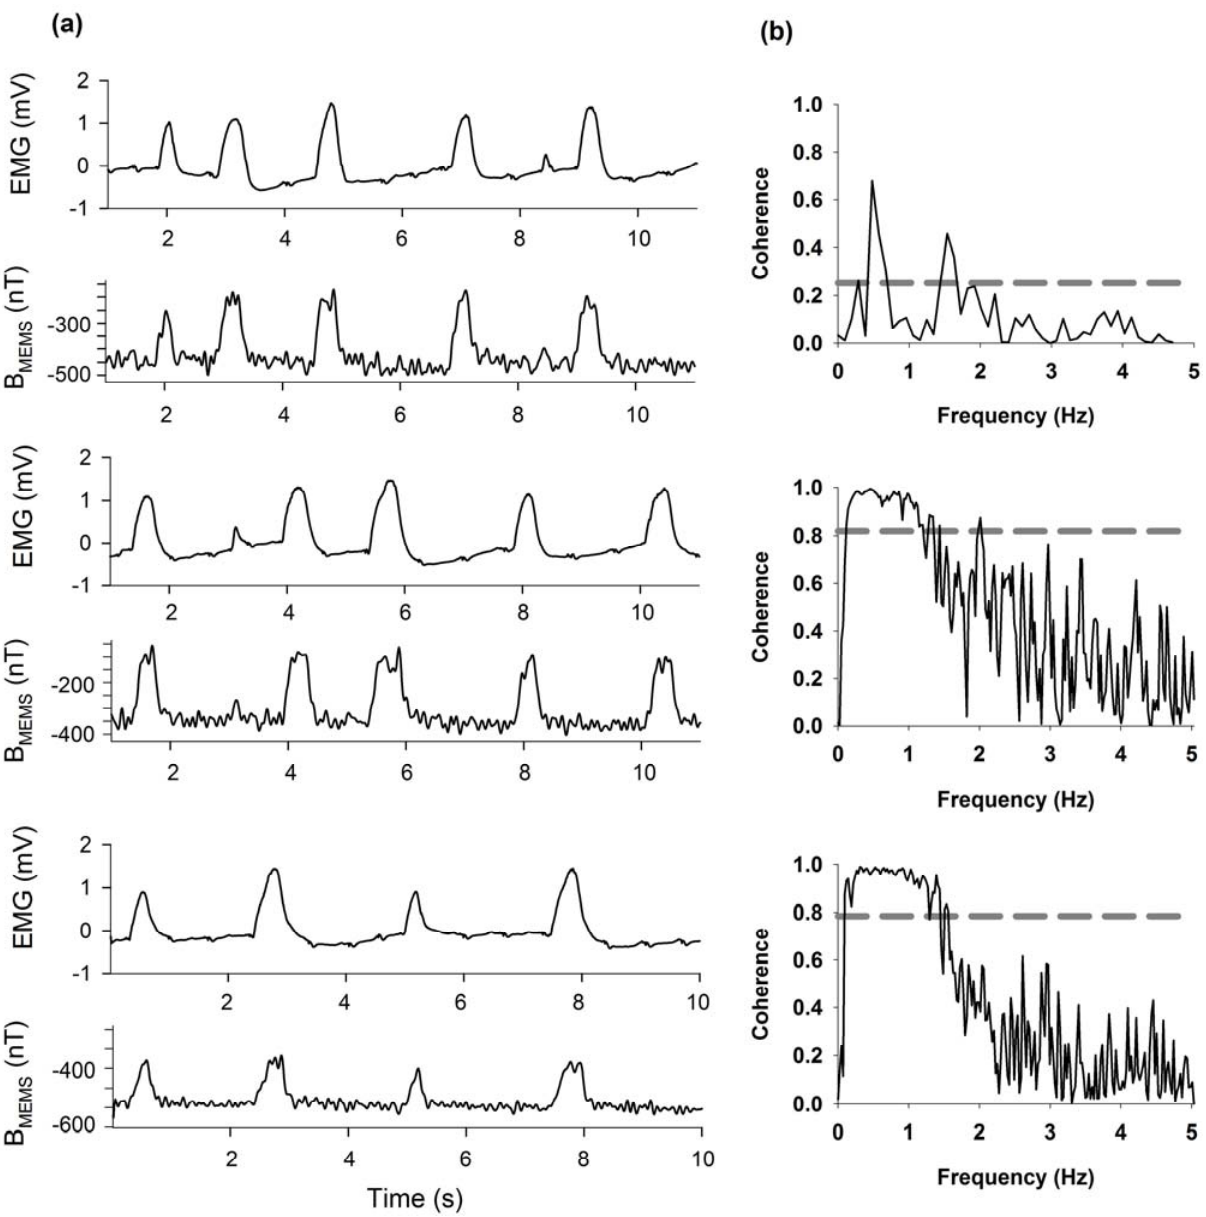
Figure 10. ( a ) Electromyogram recordings during intact respiration and the corresponding magnetograms detected with our MEMS device. The MEMS was placed 4 mm away from the thorax. Here we display the continuous recordings of three intact rats. ( b ) Coherence analysis for each pair of electromyogram (EMG)/MEMS recordings. The lower frequencies associated with the respiratory cycle exhibited the highest coherence between recordings. Interrupted lines represent the magnitude of a 95% confidence interval. B indicates the magnetic flux